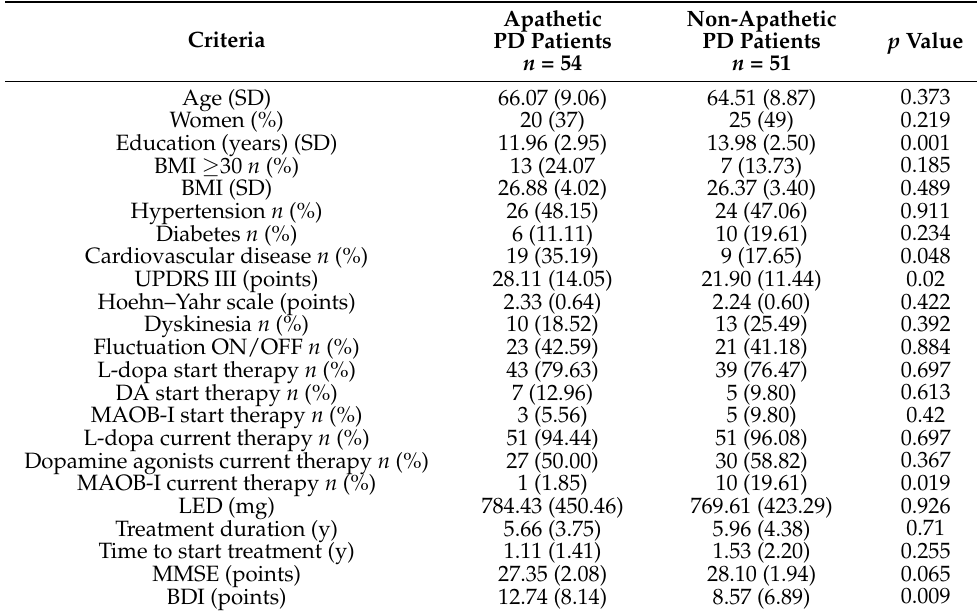
Table 1. Demographic and clinical characteristics of the participants